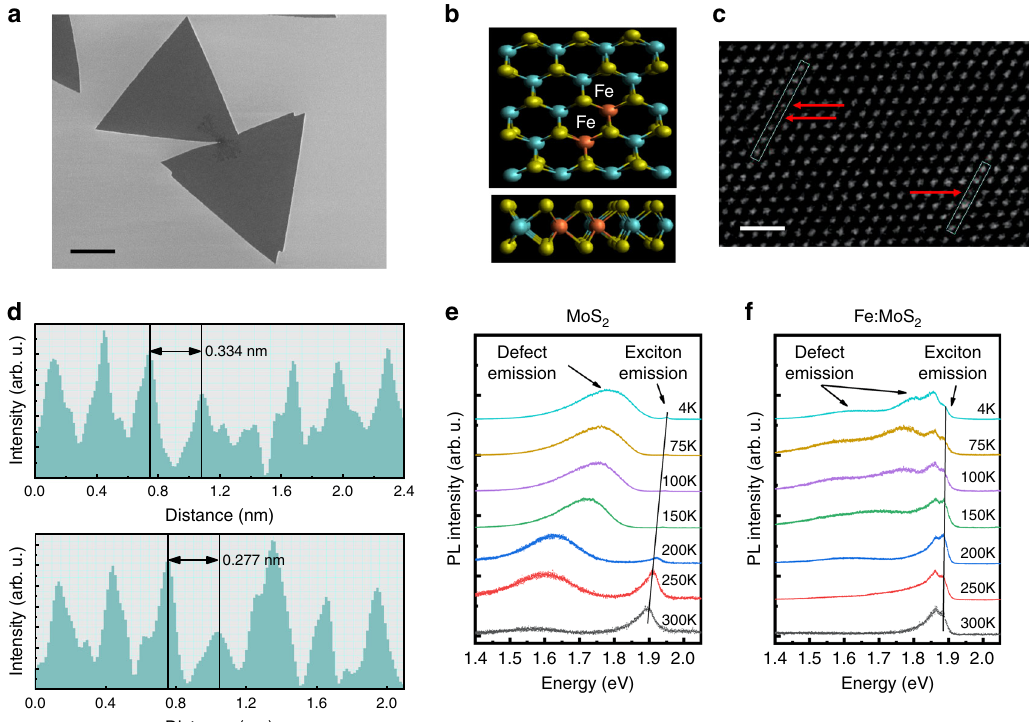
Fig. 1 Fe:MoS 2 monolayers. a SEM image of the as-grown Fe:MoS 2 monolayer. Scale bar = 4 µ m. b Schematic top and side view of the monolayer. The green, blue, and red spheres are sulfur, molybdenum and iron atoms, respectively. c Contrast-corrected STEM image of the as-grown Fe:MoS 2 monolayer. Scale bar = 1 nm. d STEM intensity spectra of the selected area, where the Fe atom exhibits ∼ 40% lower intensity. Temperature-dependent PL from ( e ) as- grown MoS 2 ( f ) Fe:MoS 2 . All PL spectra are taken under 100 µ W pump